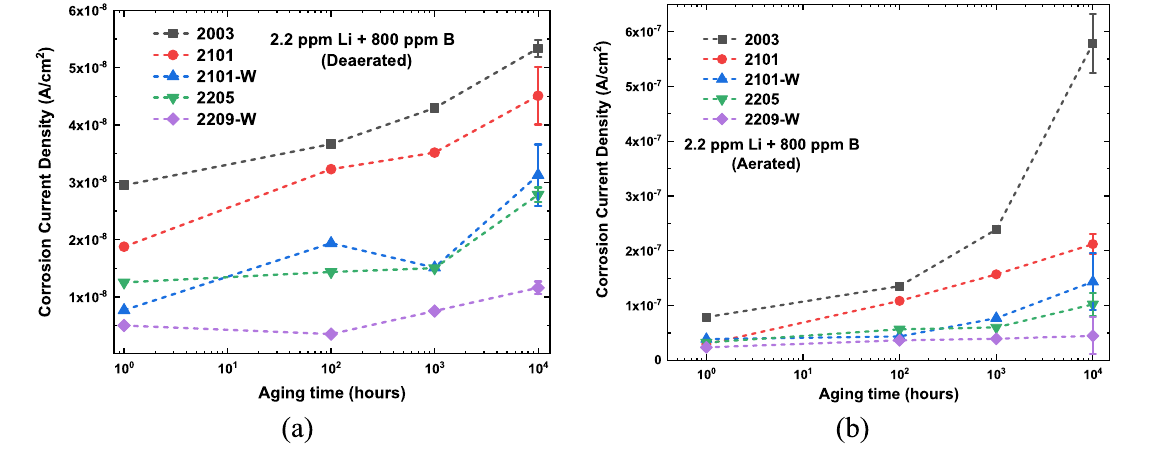
of corrosion current density for all DSS alloys. Note that corrosion current density in aerated conditions is approximately an order of magnitude larger than those in deaerated